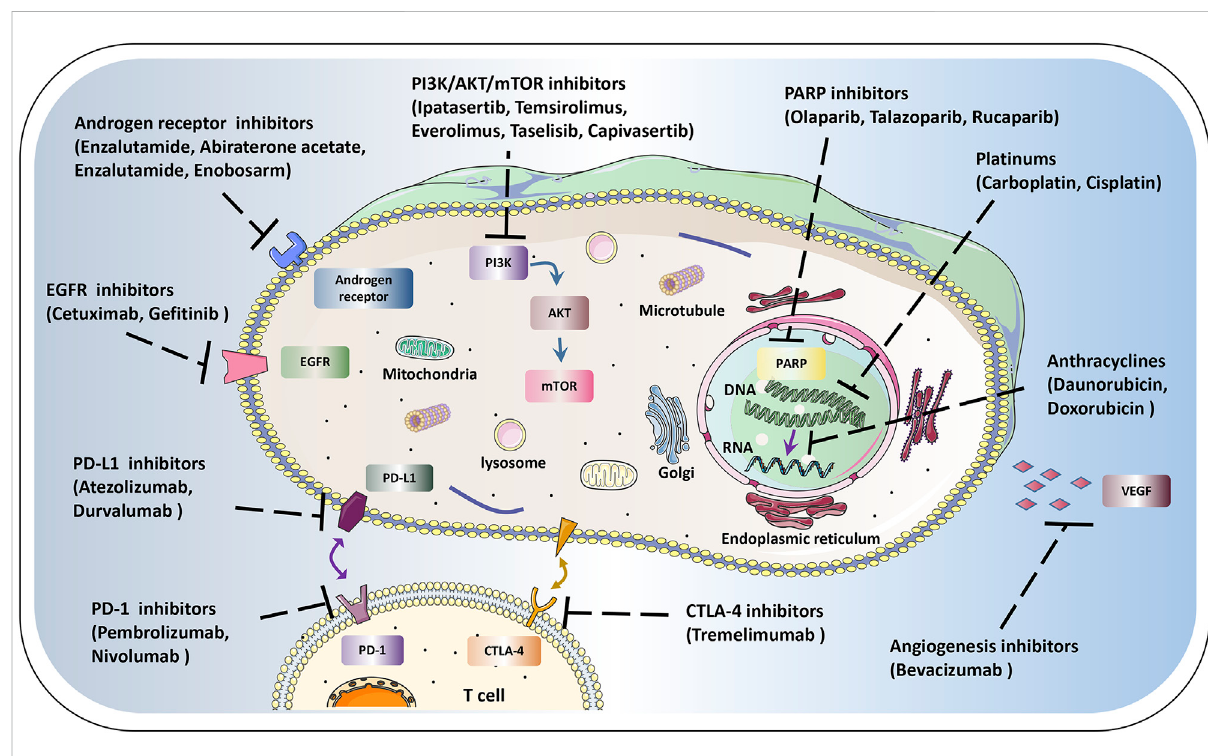
FIGURE 1 Schematic diagram of therapeutic targets in tumor cells. The current landscape of personalized clinical treatments for TNBC, mainly include anthracyclines platinums, PARP inhibitors, AR inhibitors, ICIs, PI3K/AKT/mTOR targeted inhibitors, EGFR and VEGF inhibitors, etc. Using these novel single or combination therapies will bene fi t the prognosis of